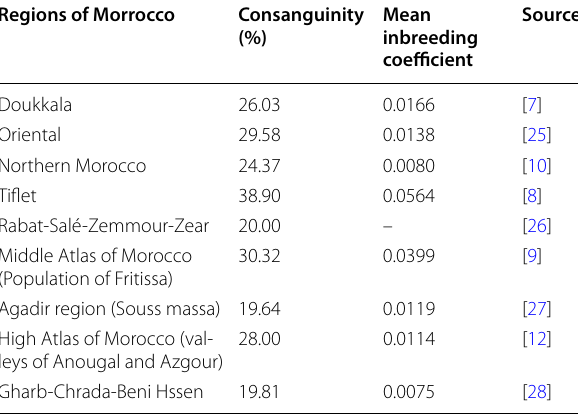
Table 6 The prevalence of consanguineous marriages in various regions of Morocco Regions of Morrocco